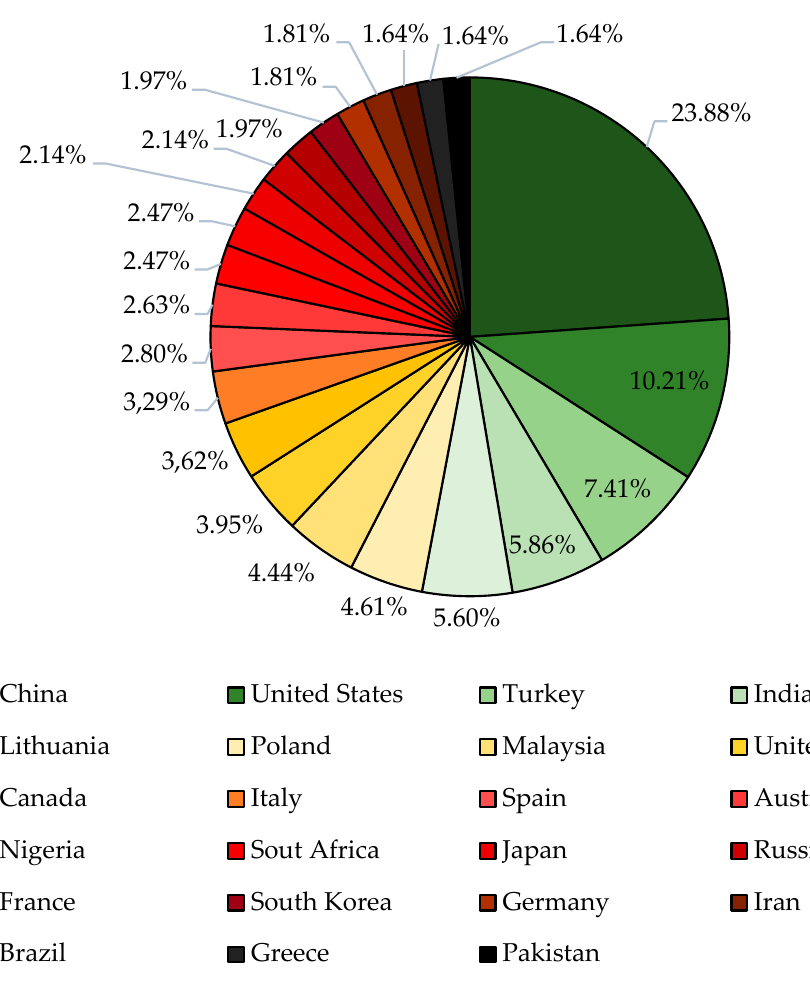
Figure 2. Share of articles per country (%). Source: own study based on: [33].